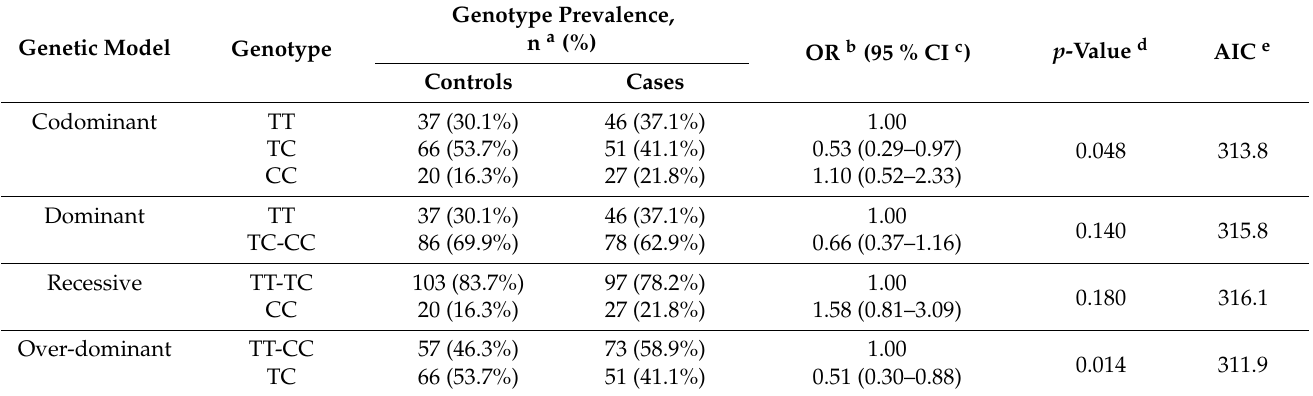
Table 4. Relationship between TLR2 rs3804099 and spontaneous preterm labor, adjusted for ane- mia and vaginal bleeding in the current pregnancy, and for threatened miscarriage or PTL in previous